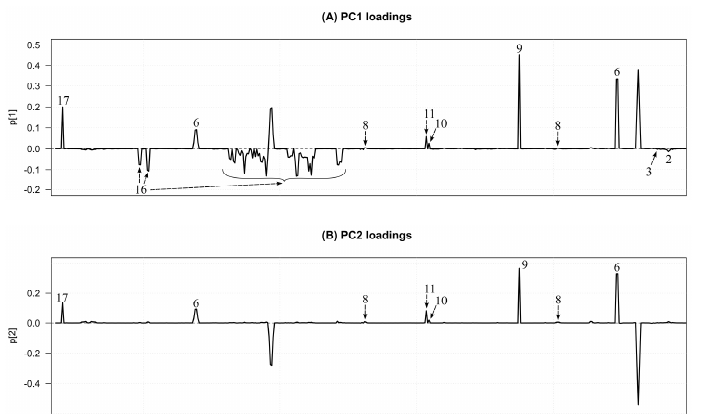
Figure A1. Loading plots of the PCA model of the full E. coli sample set: ( A ) PC1 and ( B ) PC2 loadings with the x-axis reversed to mimic the chemical shift axis of a 1 H NMR spectrum. Significant metabolite and their labels are presented in Table 1.